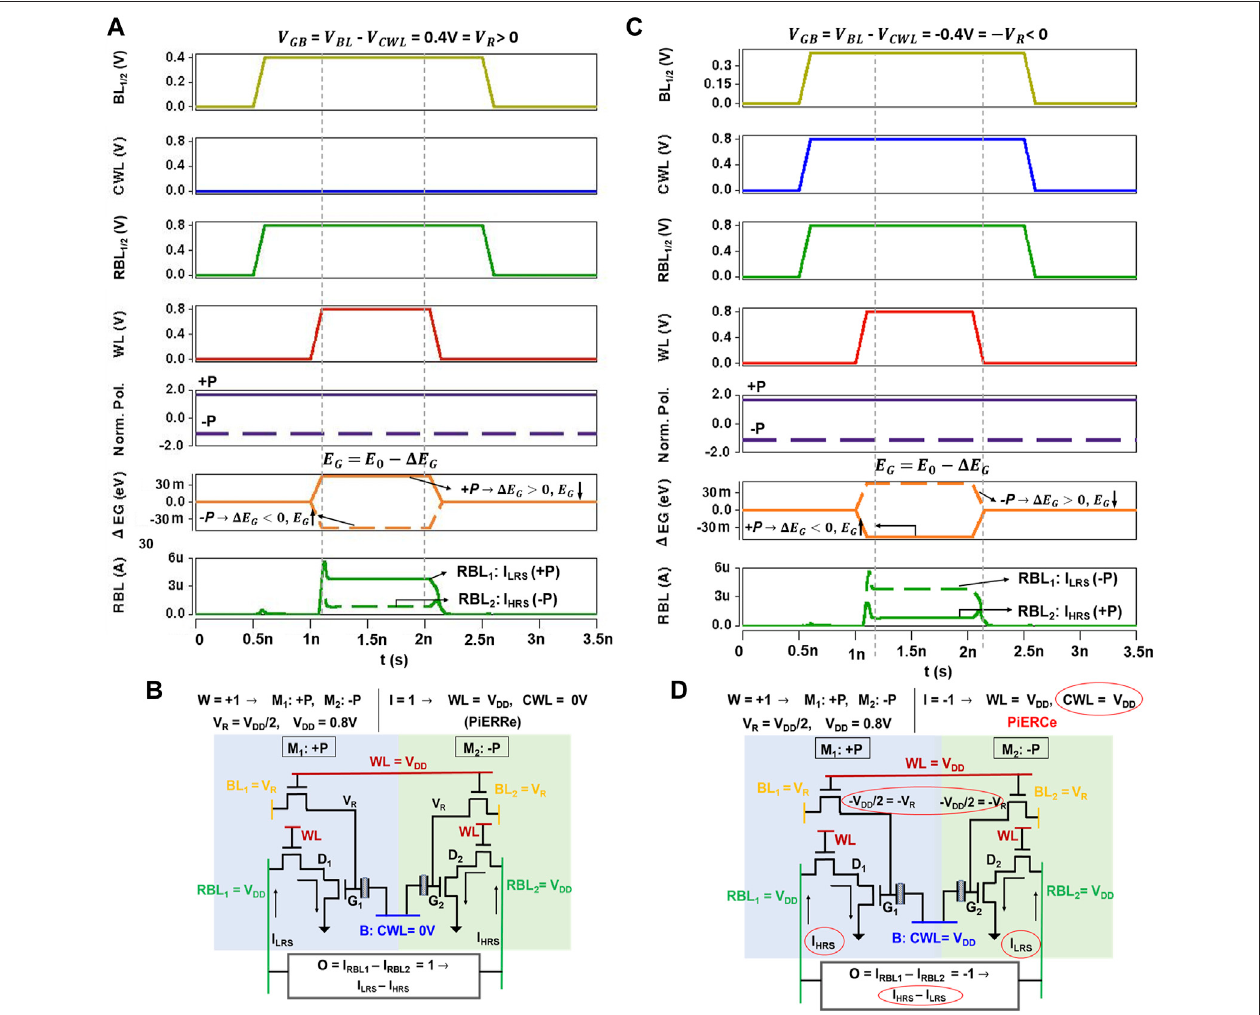
FIGURE7| Waveformof (A) readoperationshowing I LRS for+ P and I HRS for − P when V GB = V R ( PiERRe mode).Thiswaveformandschematicrepresentationin (B) showscalarproductwith W =1(+ P in M 1 and − P in M 2 )and I =1(correspondingto CWL =0 Vand WL = V DD ),resultingin I LRS on RBL 1 dueto+ P in M 1 and I HRS on RBL 2 due to − P in M 2 . (C) Waveform and schematic representation in (D) depicting the scalar product with W = 1 (+ P in M 1 and − P in M 2 ) and I = − 1 (in the PiERCe mode correspondingto CWL = V DD and WL = V DD ).Thisresultsin I HRS on RBL 1 dueto+ P in M 1 beingsensedasHRSdueto I = − 1and I LRS on RBL 2 dueto − P in M 2 being sensed as LRS due to I = − 1. For the same weights, currents on RBL 1 and RBL 2 for I = 1 (waveform A) are swapped for I = − 1 (waveform B) due to difference in CWL (highlighted with red